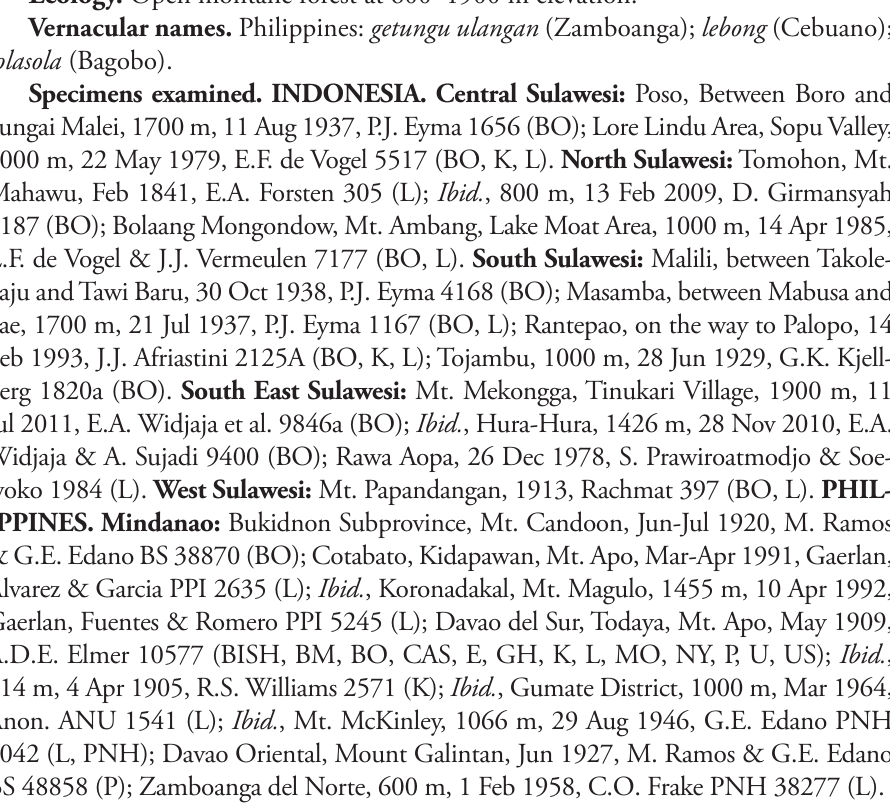
Description. Hypanthium campanulate-funneliform, 3–4 × ca. 1 mm long, densely covered with brown stellate-furfuraceous hairs; calyx lobes truncate with small trian- gular tips, ca. 1 mm long, glabrous, purple inside; petal bud conical, 2–2.5 mm long. Fruits ovoid, 5–8 × 3–5 mm long, densely covered with stellate hairs and becoming glabrous when mature, calyx lobes persistent, erect, ca. 1 mm long. Distribution. Sulawesi and Philippines